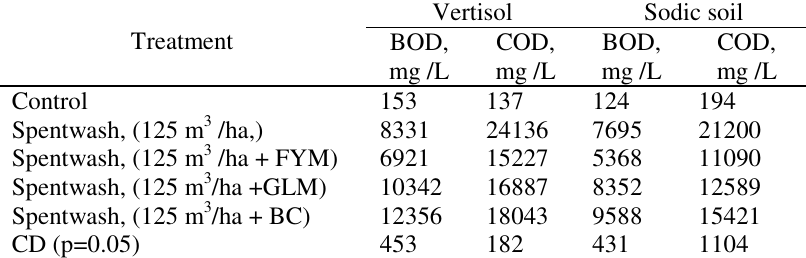
Table 5 . BOD and COD of leachate collected from vertisol and sodic